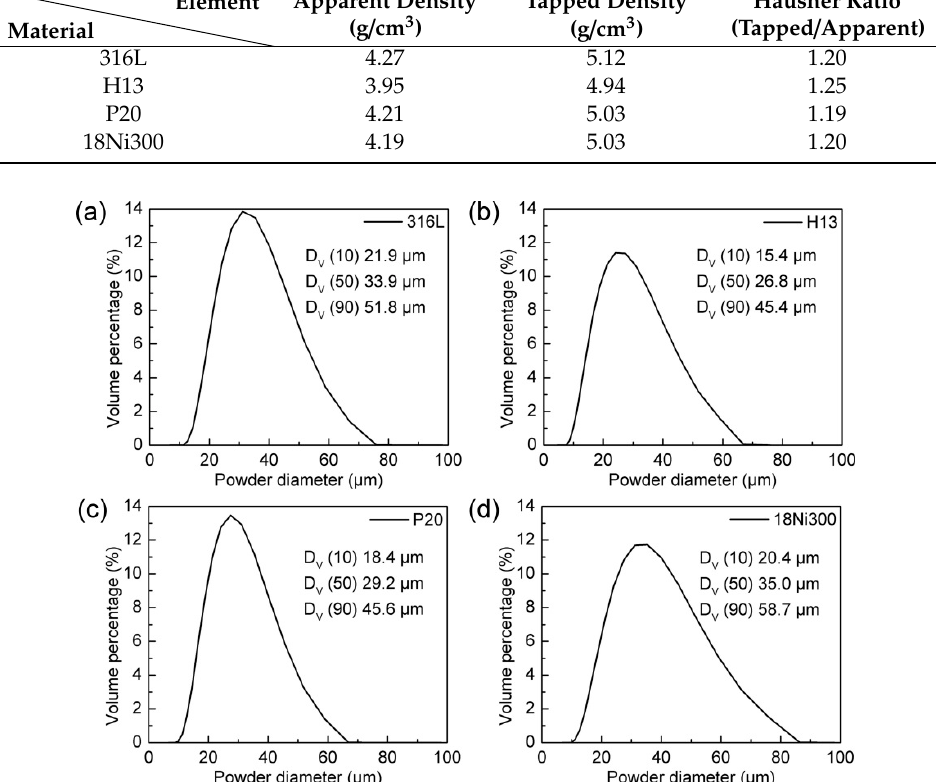
Figure 1. Size distributions of ( a ) 316L, ( b ) H13, ( c ) P20 and ( d ) 18Ni300 powder particles. Table 1. Chemical composition (wt. %) of the four steel powders.